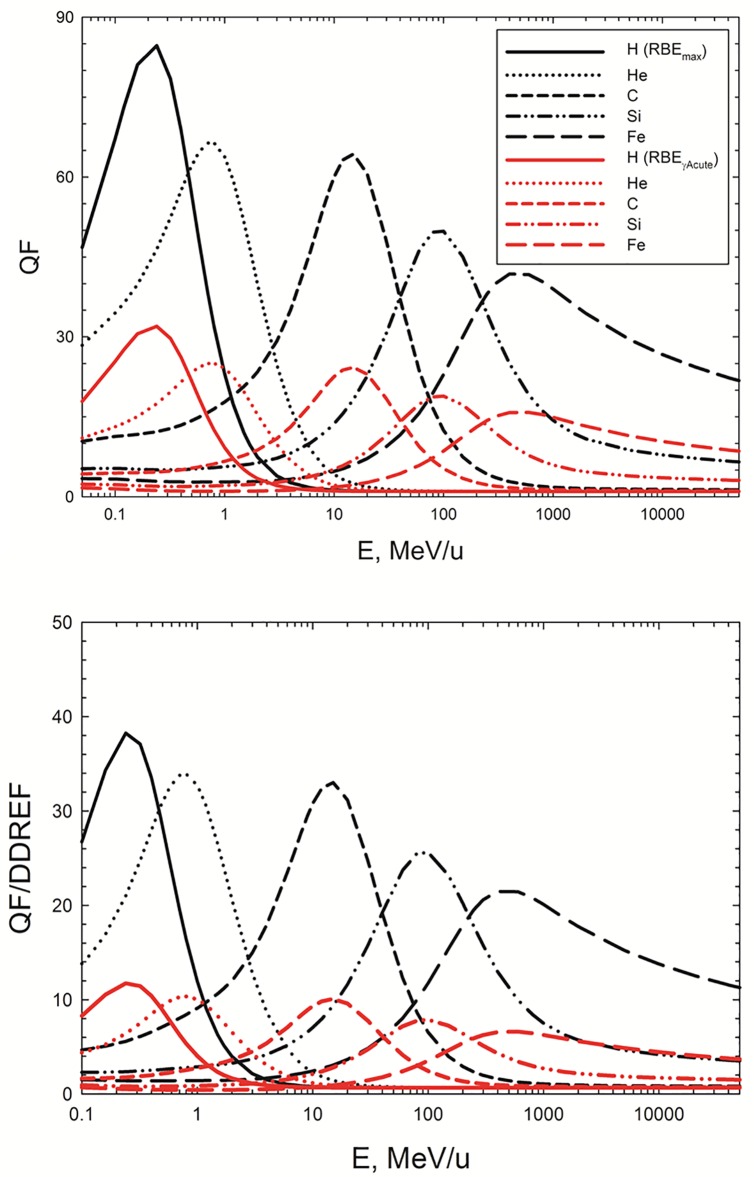
The quality factor (QF) or the ratio of the QF to the dose and dose-rate reduction effectiveness factor (DDREF), QF/DDREF versus the kinetic energy for several particle types.For the DDREF the recommended value of 1.5 [30] has been applied.